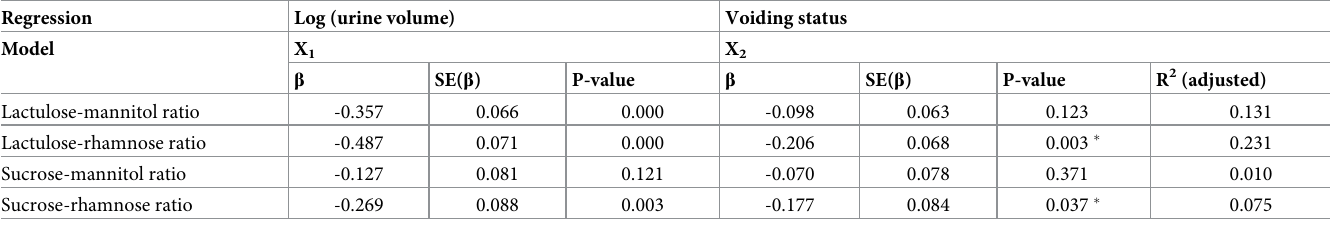
Model variables were adjusted for age and gender; � means model is significant, i.e. p <